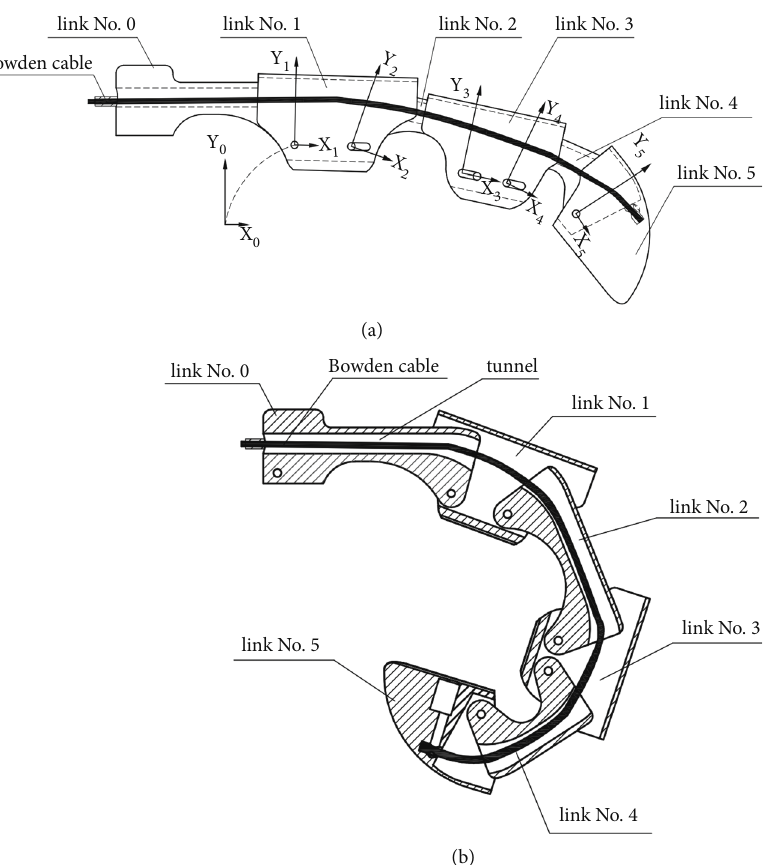
Figure 2: De fi nition of links and coordinate frames for one fi